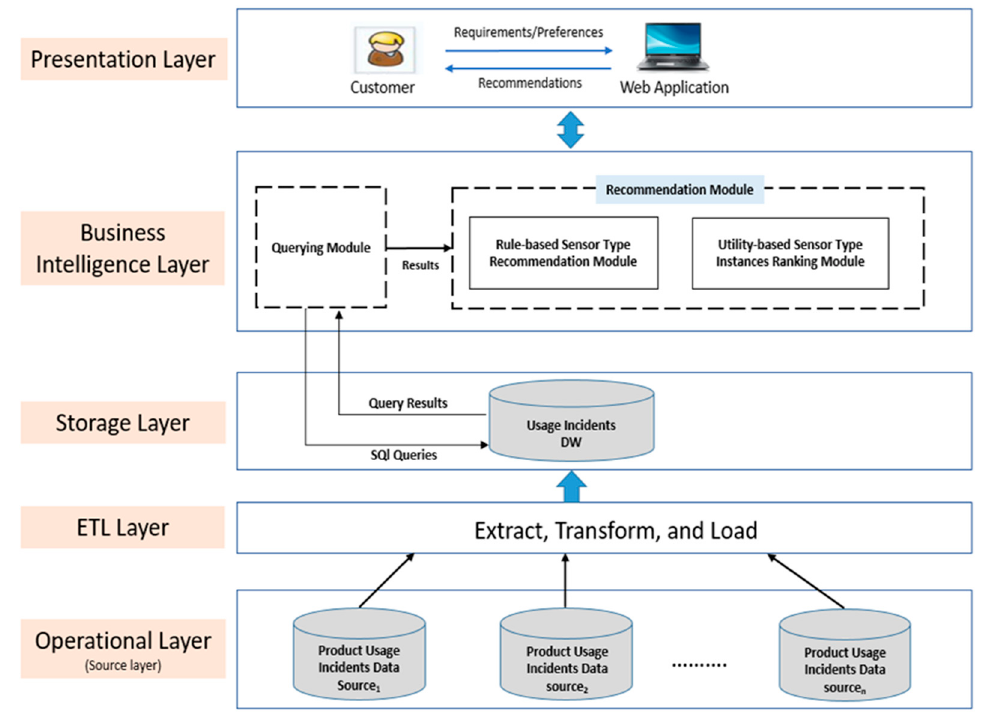
Figure 2. Proposed DW-based recommender architecture (inspired by the typical three-tier data warehouse architecture proposed in [57]).